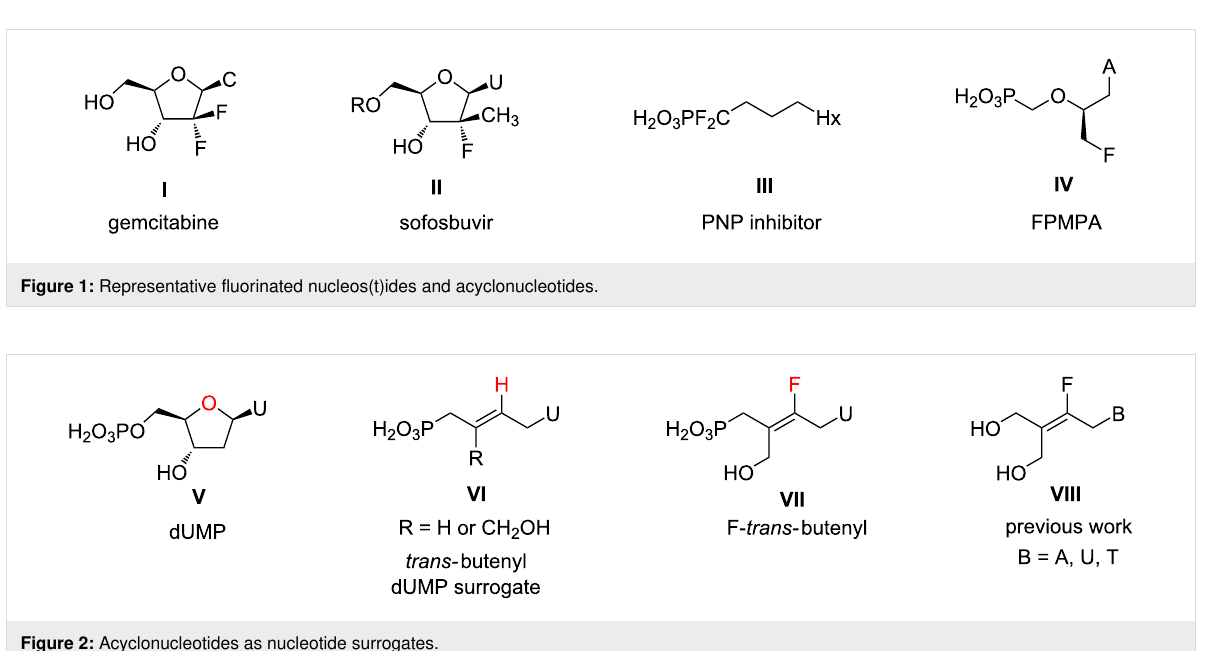
nucleotide, will improve molecular recognition and activity. In addition, the polarity of the nucleotide and hydrogen-bond accepting capacity with proteins or enzymes would be restored